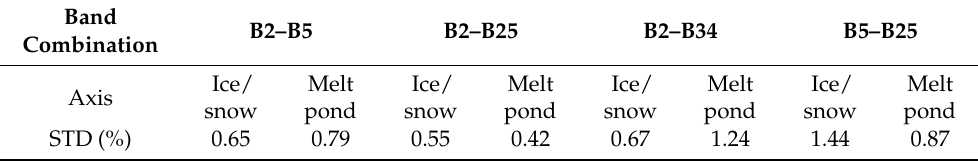
Table 4. Standard deviation of the melt pond axis and ice/snow axis for the 4 band combinations.